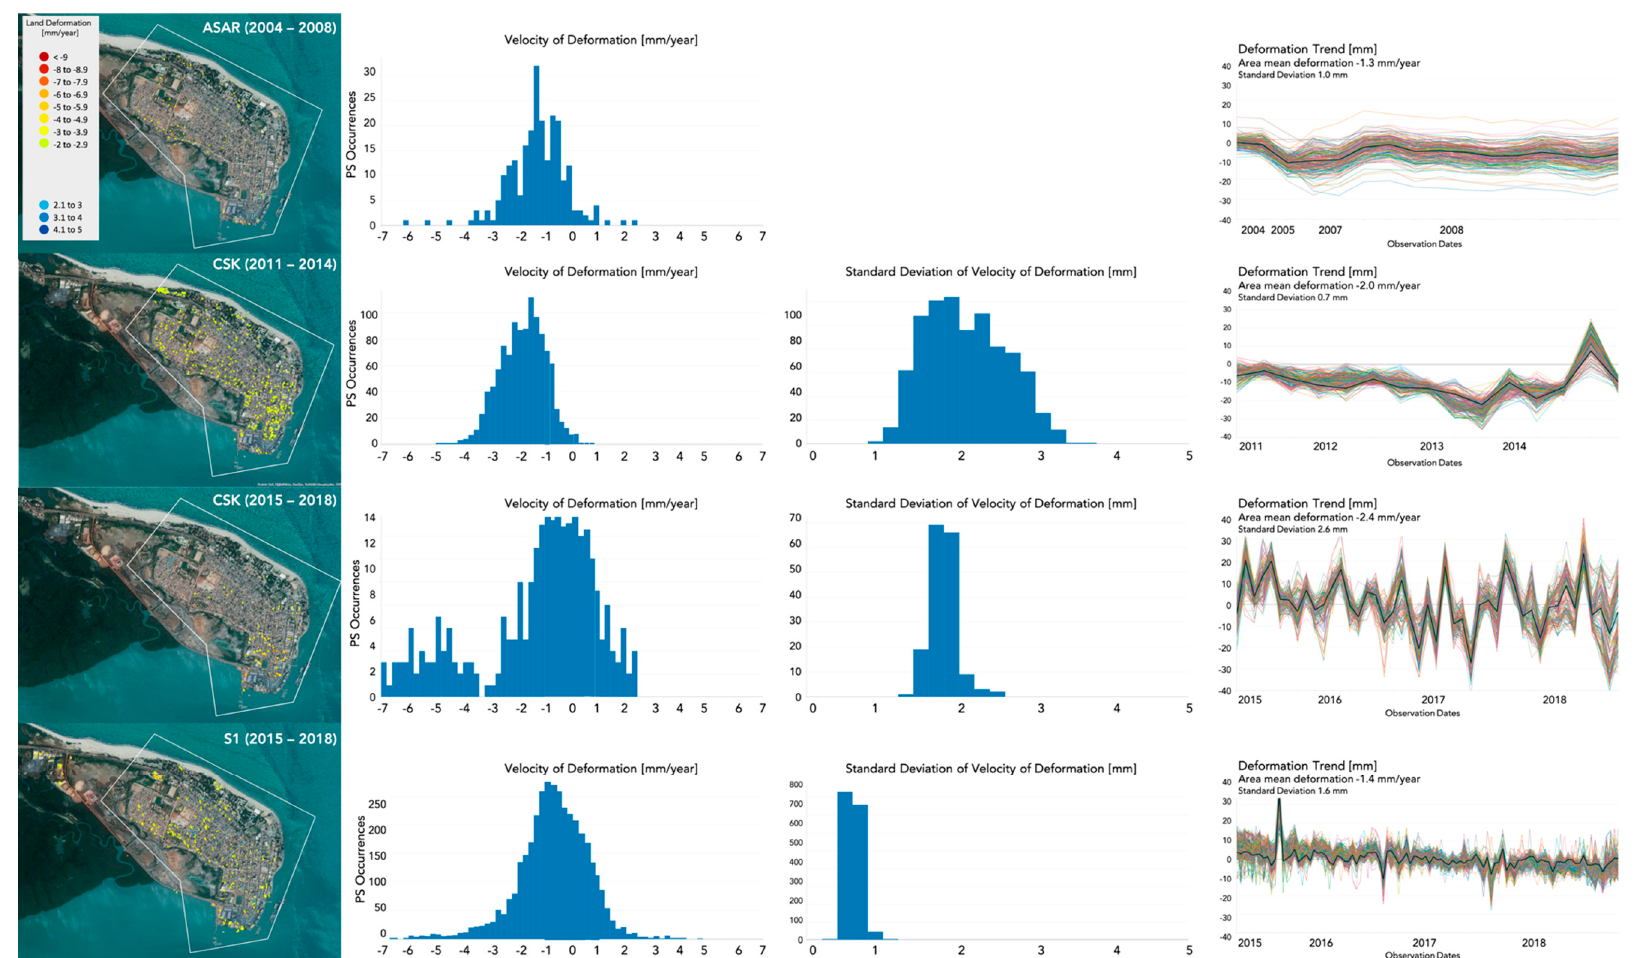
F igure 12. Banjul AOI 1. Figure 12. Banjul AOI